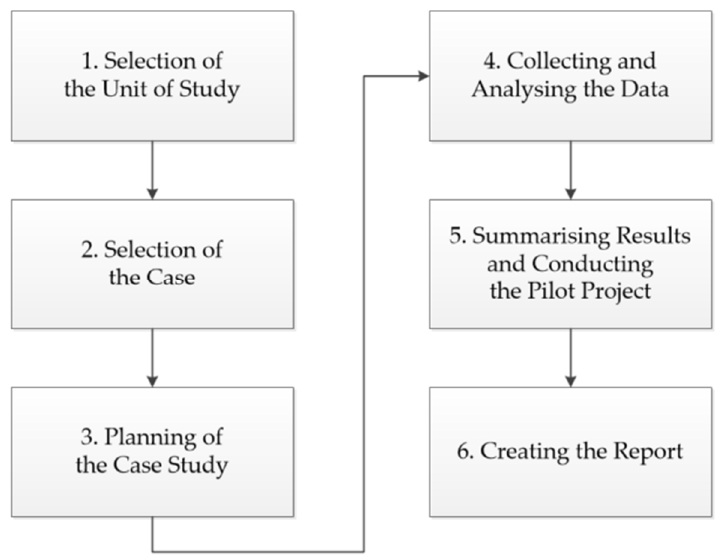
Figure 2. Case study